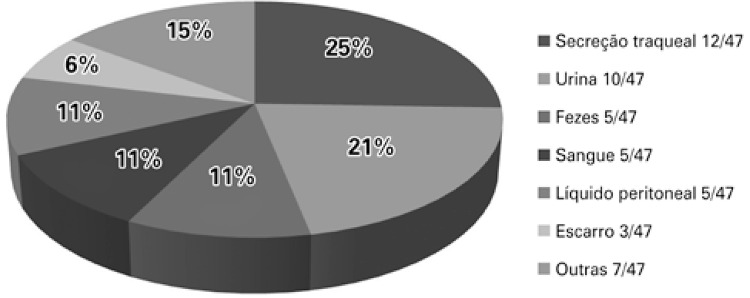
Distribuição conforme espécime clínico de isolamento das enterobactérias em estudo